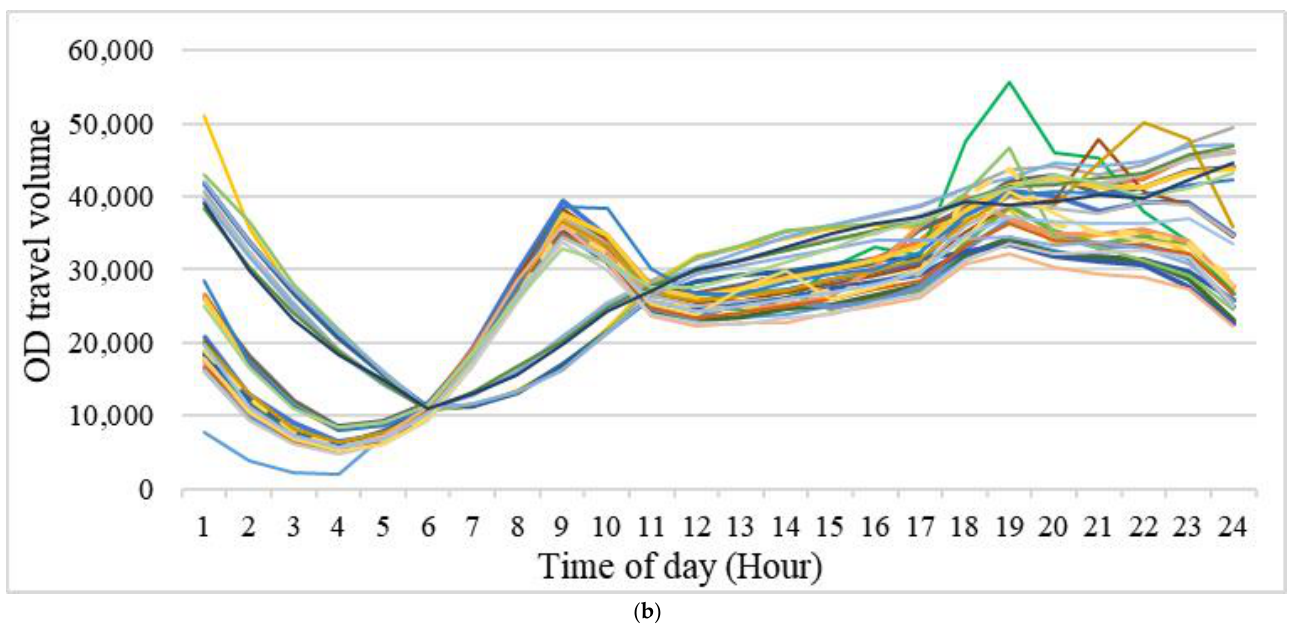
Figure 6. Hourly OD travel volume. ( a ) Shenzhen City. ( b ) New York City.